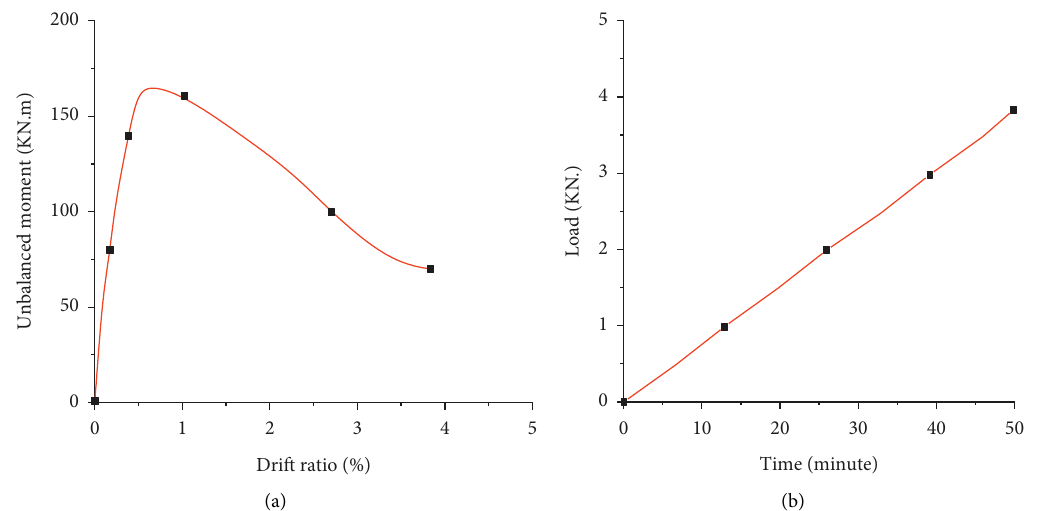
Figure 26: (a) Unbalanced moment drift ratio response and (b) drift ratio-fre exposed duration response of 0% axial load